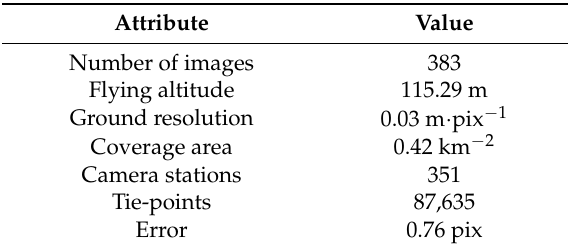
Table 1. Summary of UAV-image processing using